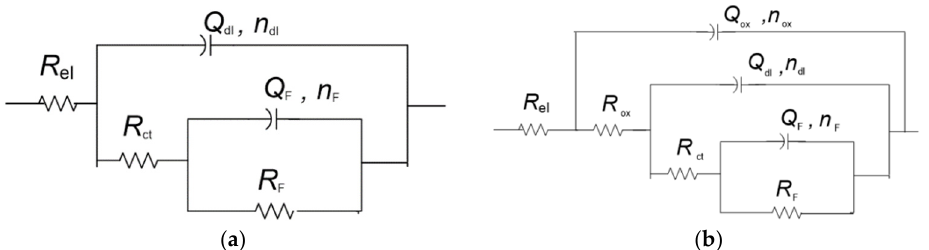
Figure 2. Electrical equivalent circuits with ( a ) two time constants and ( b ) three time constants used for analysis of EIS data. ( R el —electrolyte resistance; R ox —oxide layer resistance; R ct —charge transfer resistance; R F —faradic resistance of reactive patina; Q —constant phase elements related to oxide layer ( Q ox ), double layer capacitance ( Q dl ), or reactive patina capacitance ( Q F ); n —coefficients associated to each constant phase element).